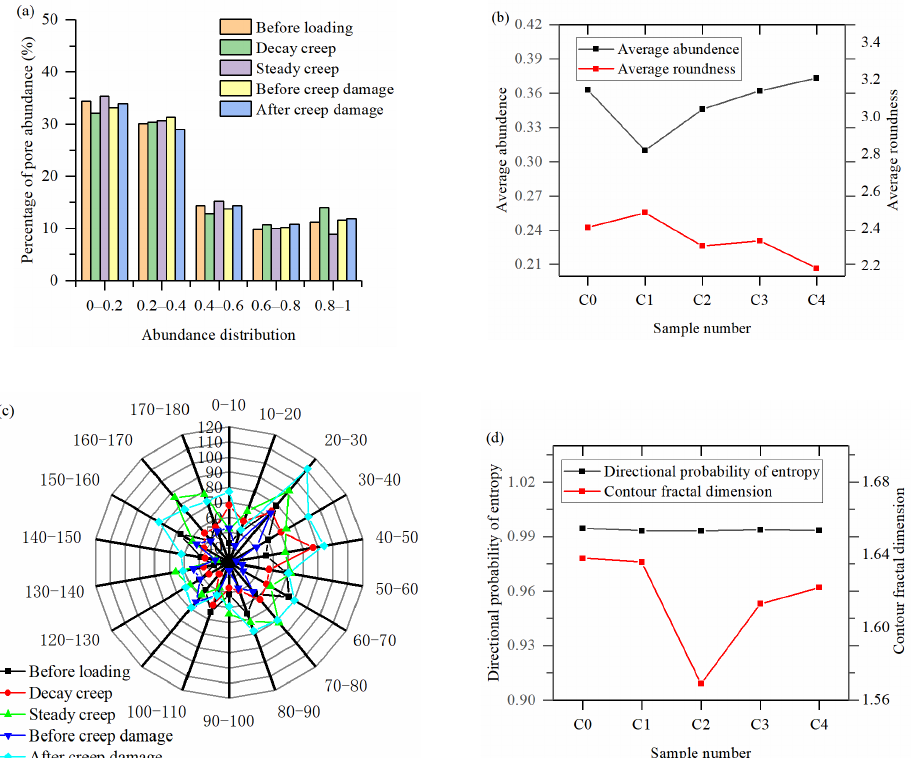
Figure 12. Quantitative analysis of pore space of remolded loess. ( a ) Histogram of pore abundance distribution; ( b ) pore abundance and roundness; ( c ) frequency diagram of pore orientation distribution; ( d ) pore orientation probability and fractal dimension.